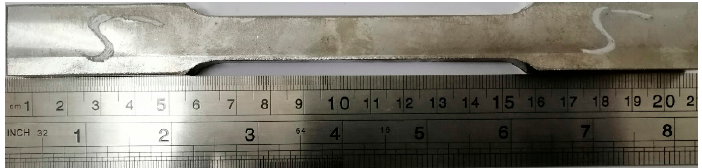
Figure 1. Tensile Test Specimen.